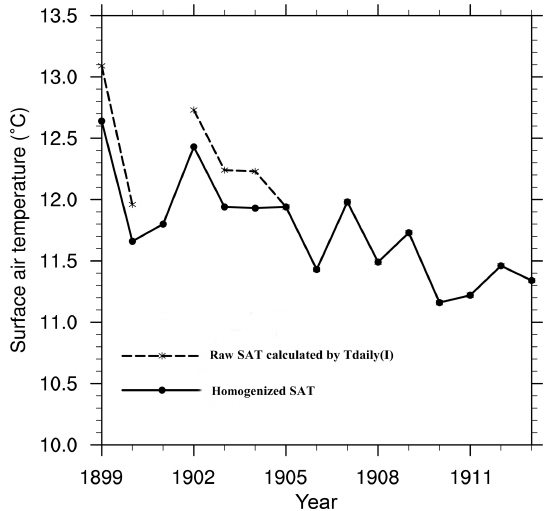
Figure 4. Annual mean SAT series ( ◦ C) of the raw and homog- enized recorded at Qingdao from 1899 to 1913. Black line is the original observation series; red line is the homogenized series.